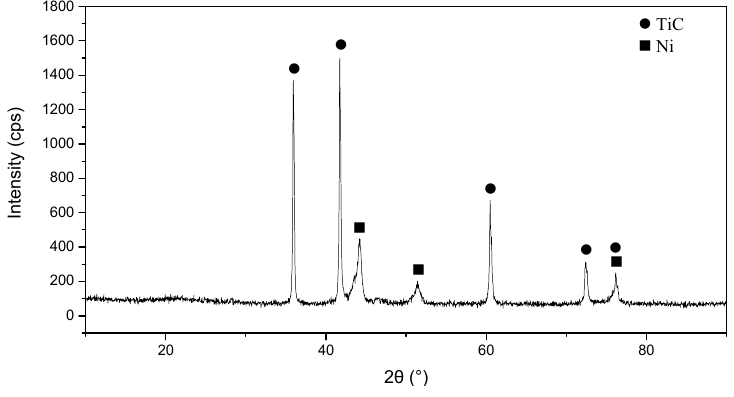
Figure 3. XRD pattern of the original coating.